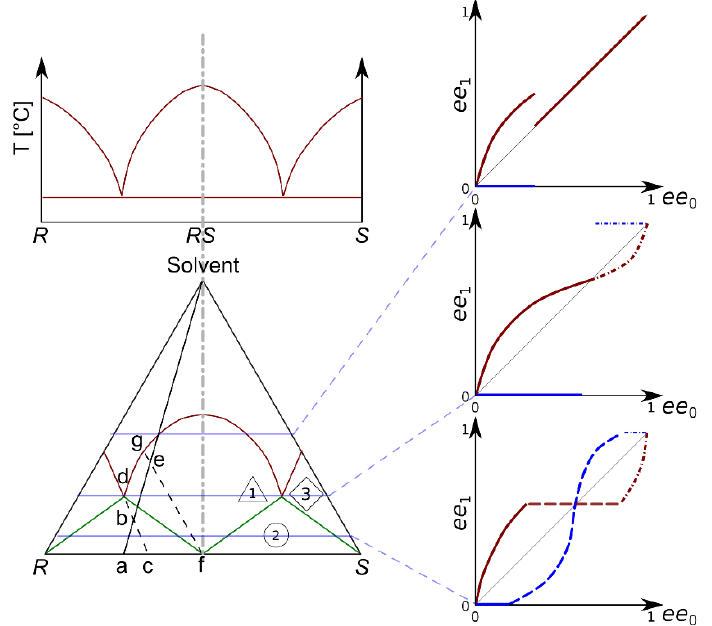
Figure 1. Comparison between a chiral temperature composition melting phase diagram and the recrystallization behavior of a hypothetical racemic compound. The diagrams on the left show the correlation between the melting phase equilibrium and the zones of the ternary solubility plot, whilst the Product ee against Initial ee diagrams on the right show the expected (idealized) product compositions in the case of different overall concentrations. The expected composition of the mother liquor is shown in maroon and that of the crystalline product is shown in blue.